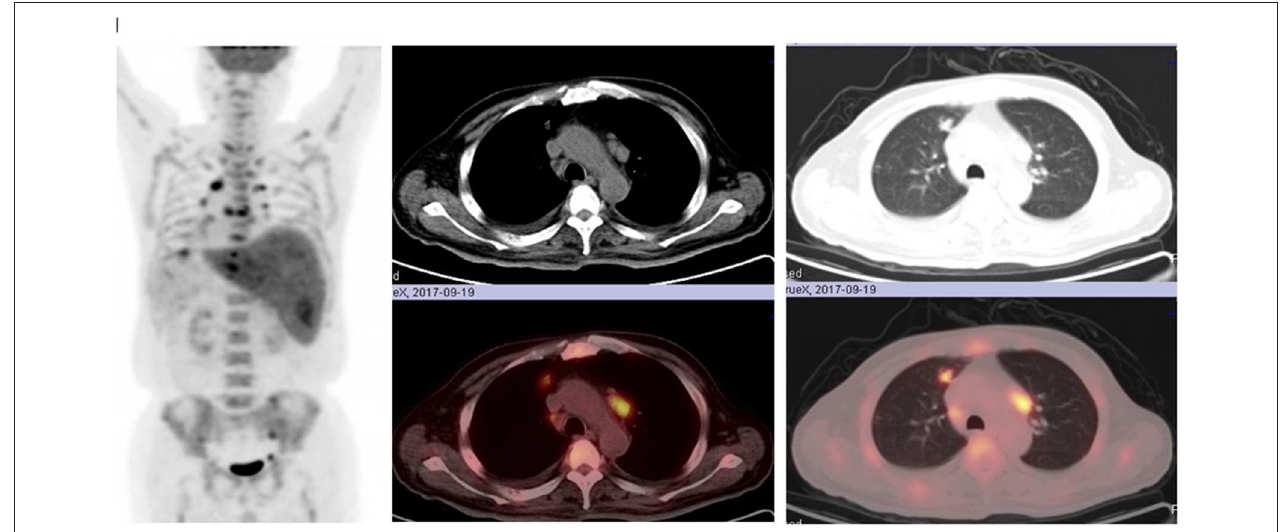
FIGURE 1 | Multiple hypermetabolic nodular lesions in the anterior segment of superior lobe of right lung, middle lobe of right lung, apico-posterior segment of superior lobe of left lung, bilateral pleura, liver, multiple bone lesions in skull, maxillae, bilateral humerus, bilateral clavicle, bilateral scapula, sternum, some vertebrae, some ribs, bilateral femurs, and the pelvis on FDG-PET CT